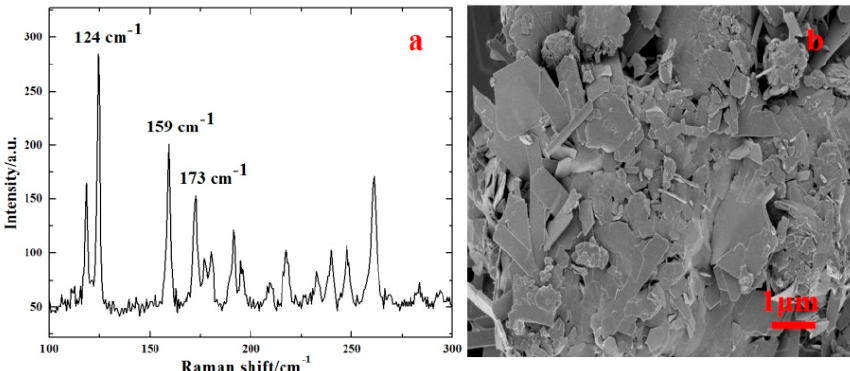
Figure 1. ( a ) Raman spectrum and ( b ) SEM image of ReSe 2 powder.